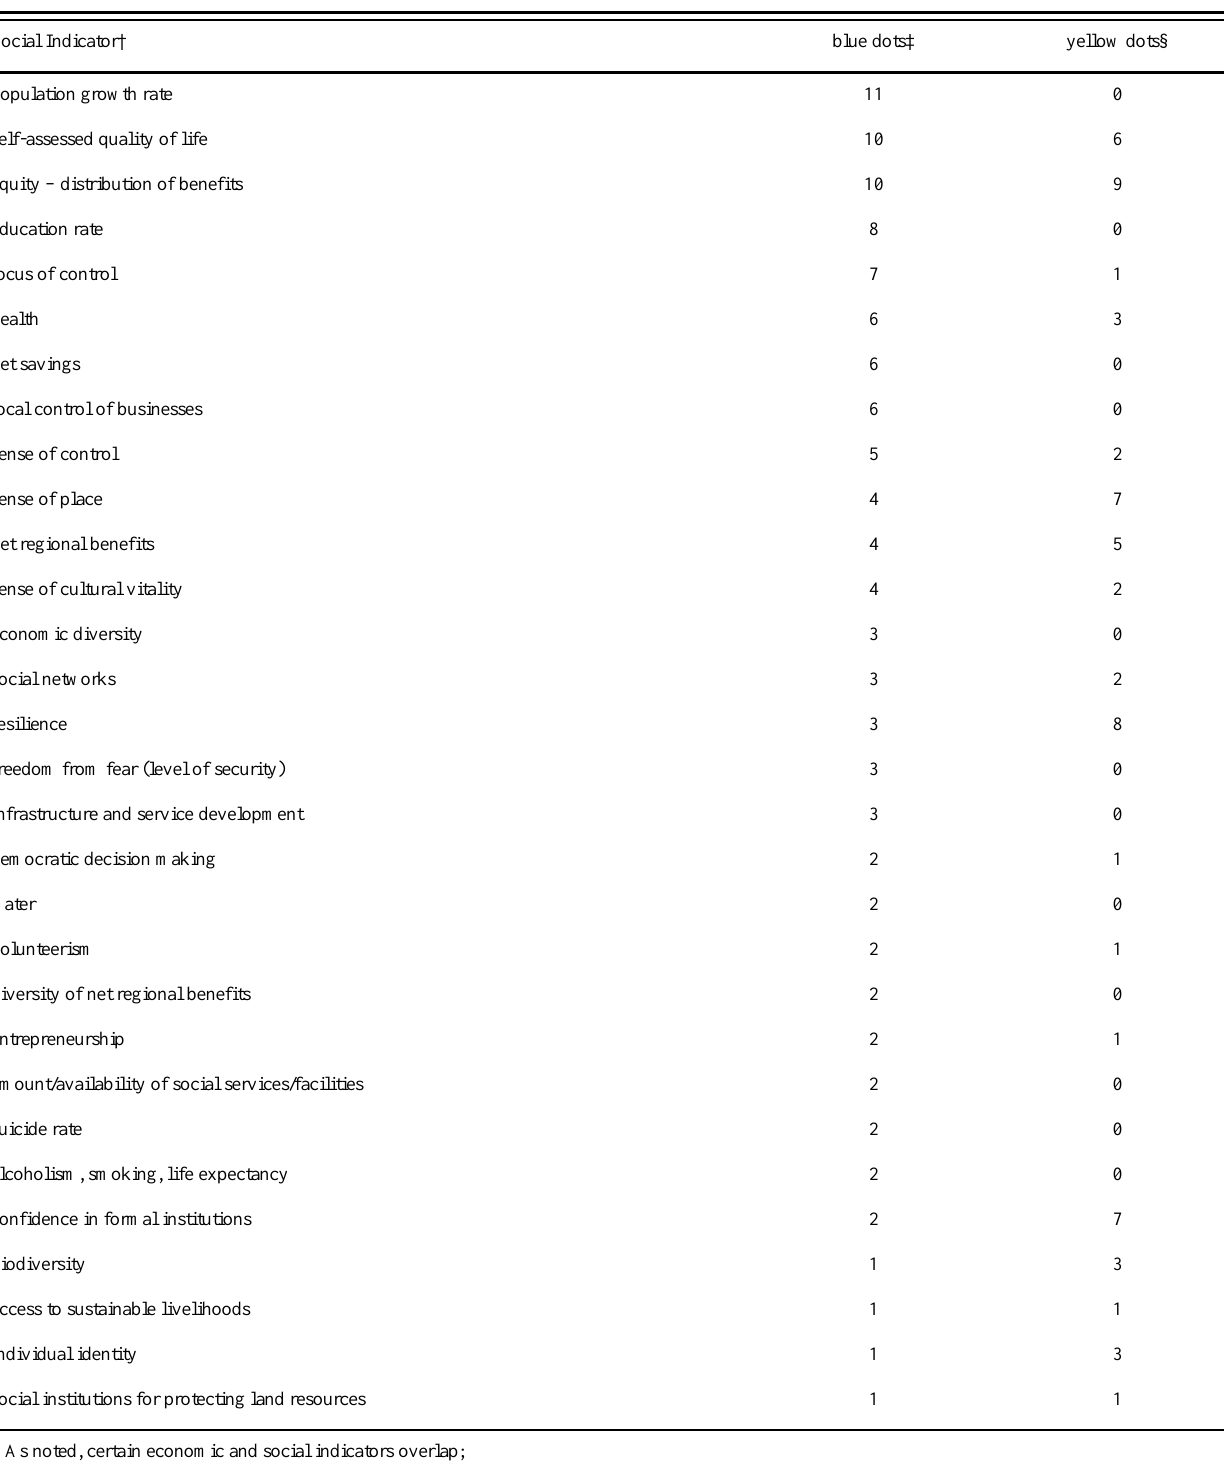
Table 1. Prioritized list of social